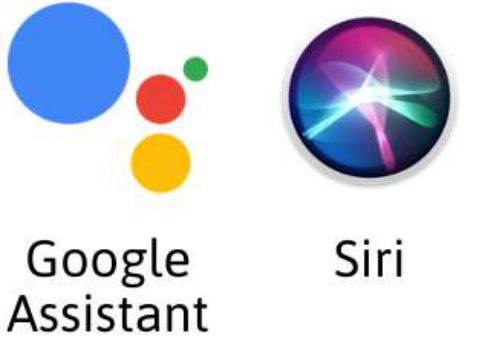
Figure 10. Typical headset button controller.